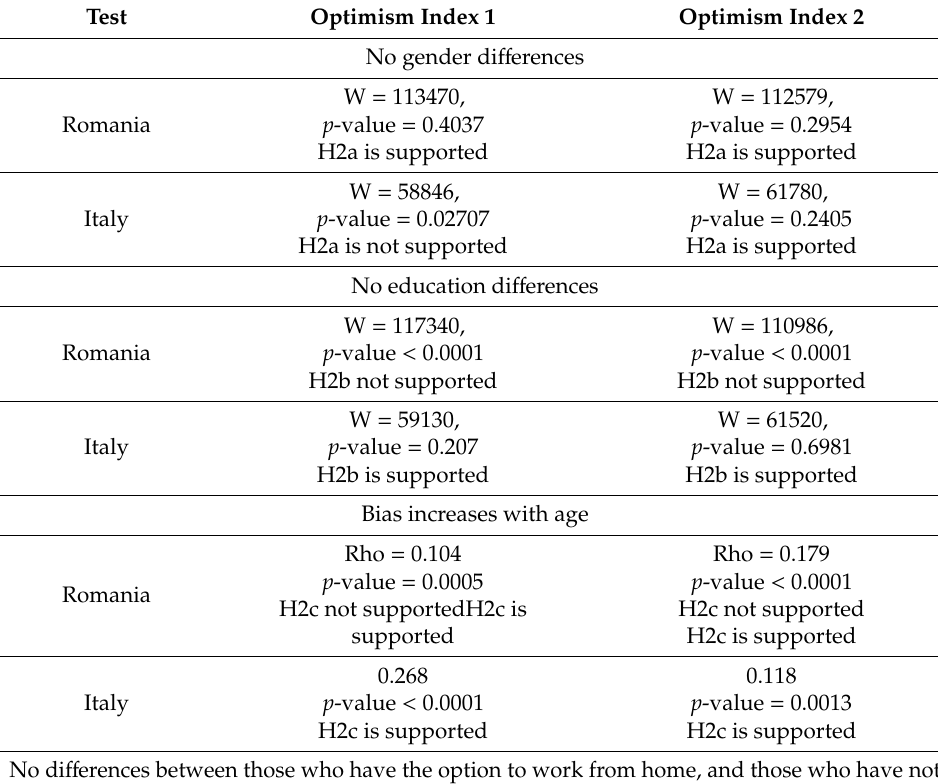
Table 6. Tests related to H2 and